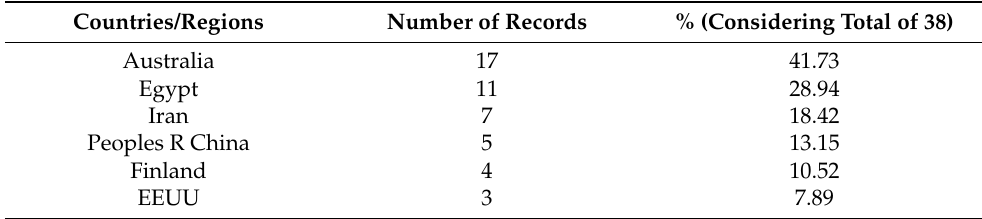
Table 1. Countries versus number of publications (data from 2018 to 2022).